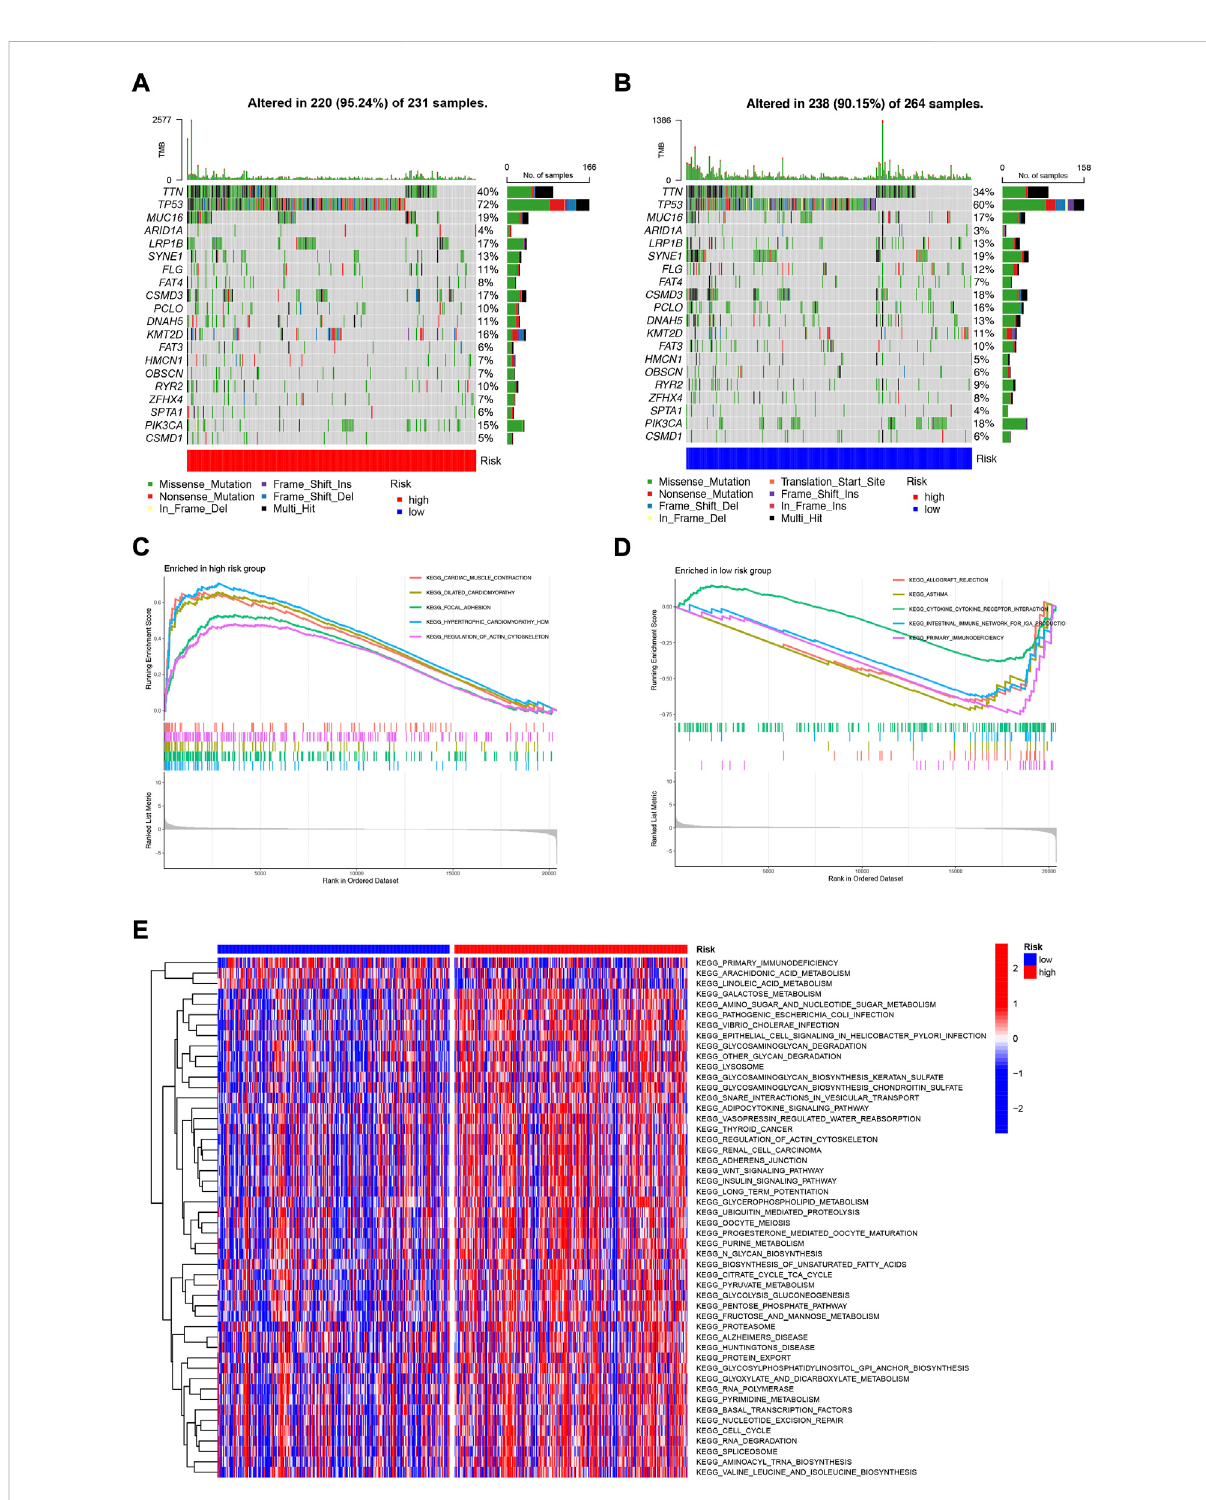
FIGURE 10 Mutationanalysisandbiologicalfunctionenrichmentanalysis (A) Mutationanalysisofhigh-riskgroup (B) Mutationanalysisoflow-riskgroup (C) Enrichment pathway of high-risk signi fi cantly up-regulated gene set (D) Enrichment pathway of low-risk signi fi cantly down-regulated gene set (E) Heat map of difference in enrichment scores between high- and low-risk